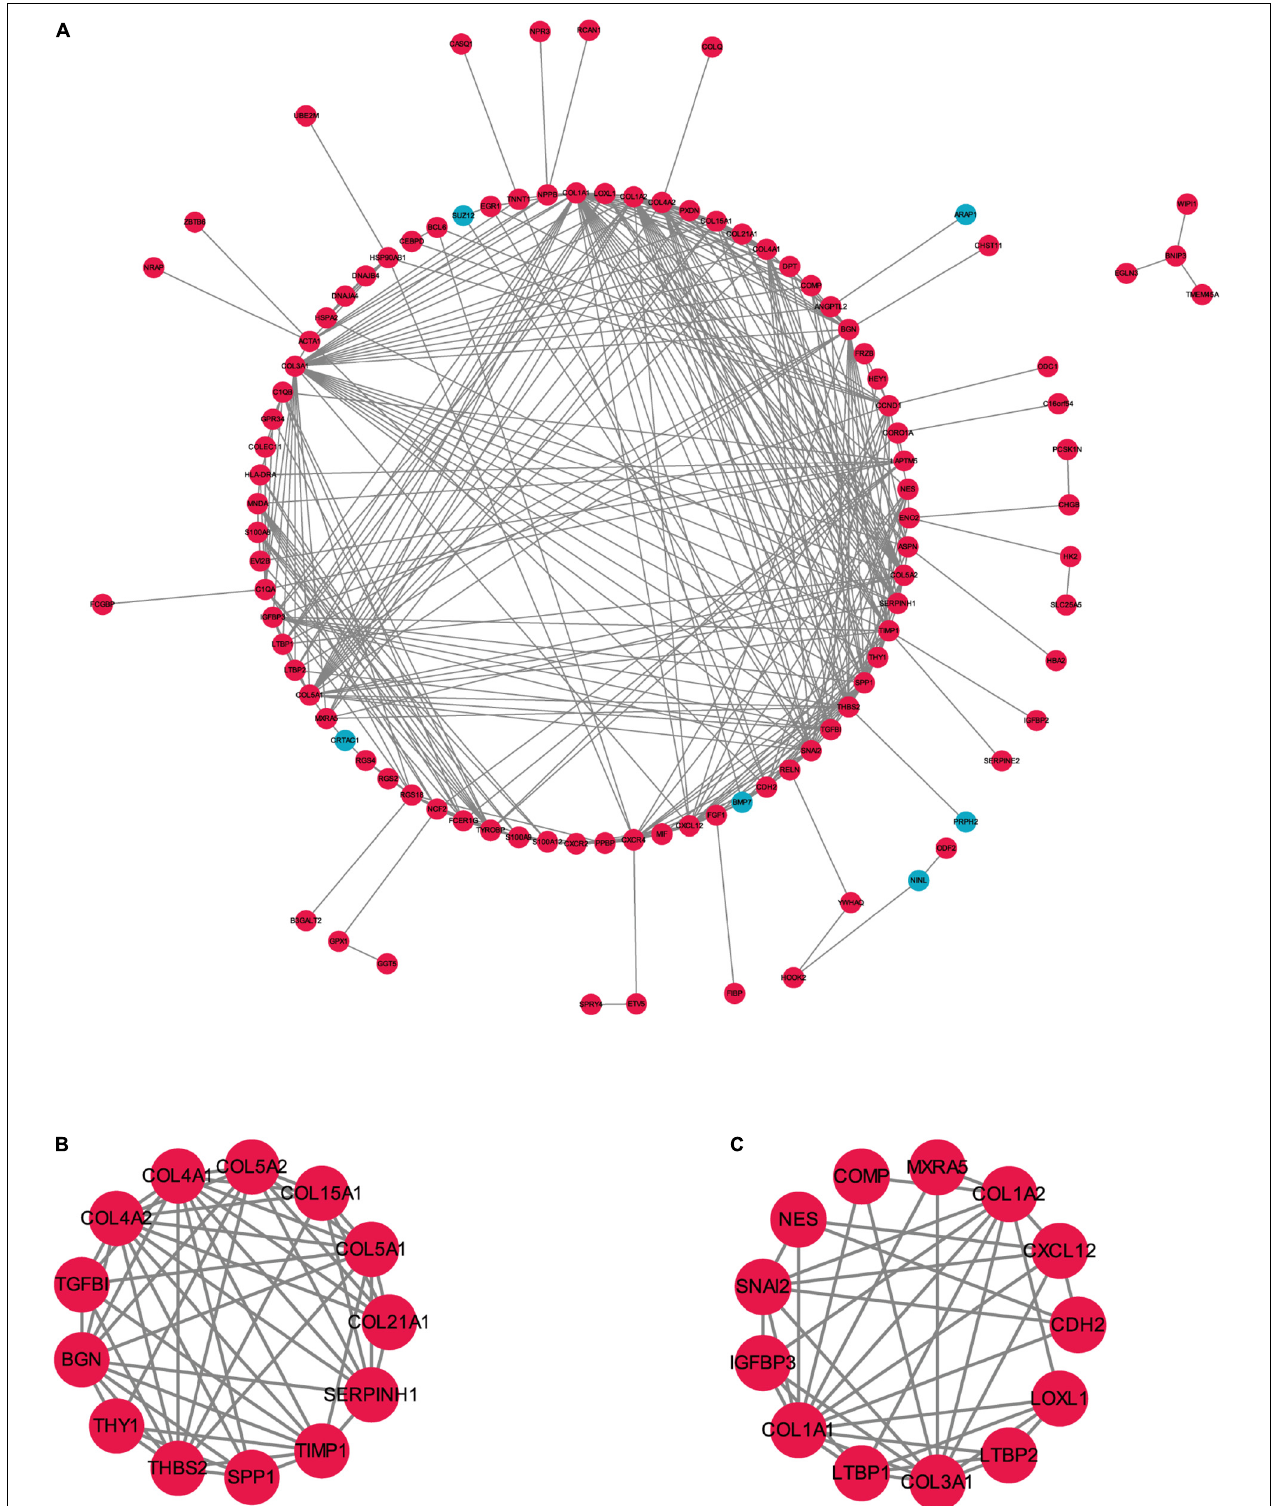
FIGURE 4 | The PPI network of the robust DEGs. (A) PPI network of upregulated and downregulated significant genes. (B,C) The most significant two modules identified through MCODE in Cytoscape software. PPI, protein–protein interaction; DEG, differentially expressed gene. Red indicates upregulation of genes, and blue represents downregulation of genes in AF